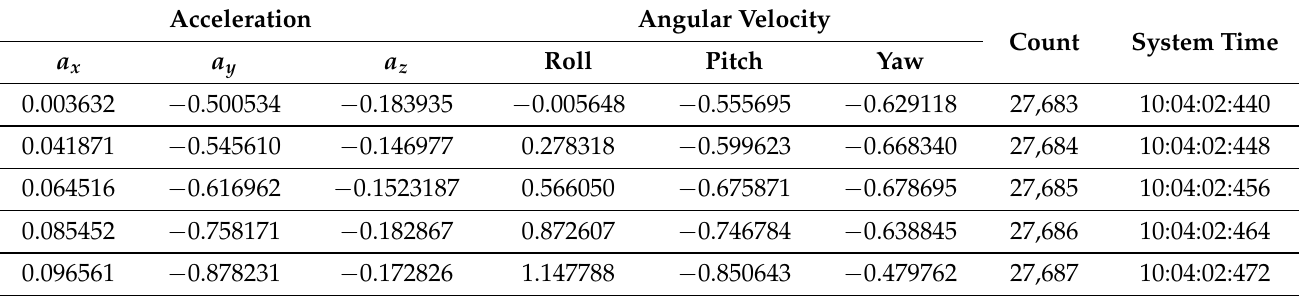
Table 1. Illustration of the input inertial measurement